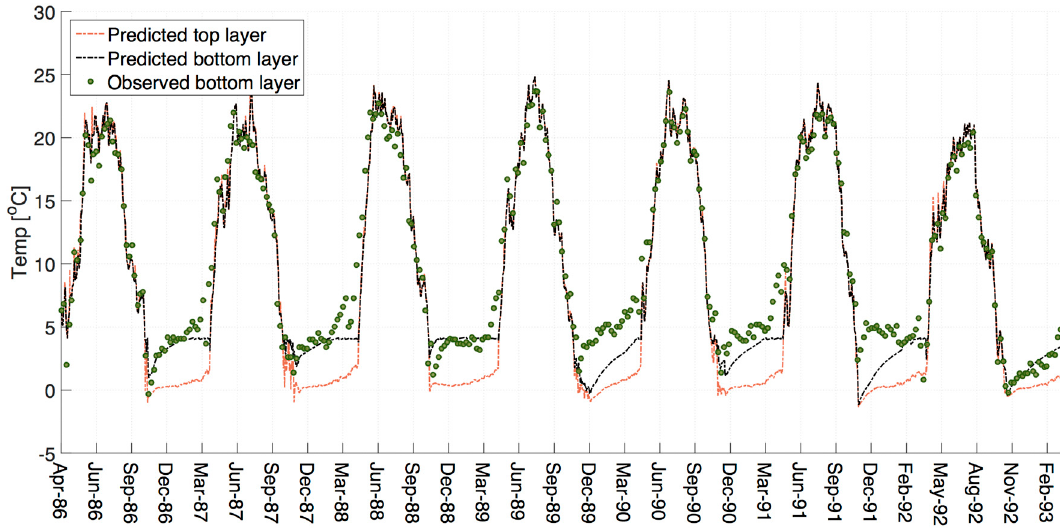
Figure 2. Results of the water temperature model. Compares predicted temperatures in the same grid cell as the Buffalo Pound Water Treatment Plant weekly observations. Note that CE-QUAL-W2 converts the negative water temperature modelled at the start of each winter to equivalent ice thickness. Root mean square error = 1.46 (to 2 dp); mean absolute error = 1.12 (to 2 dp).